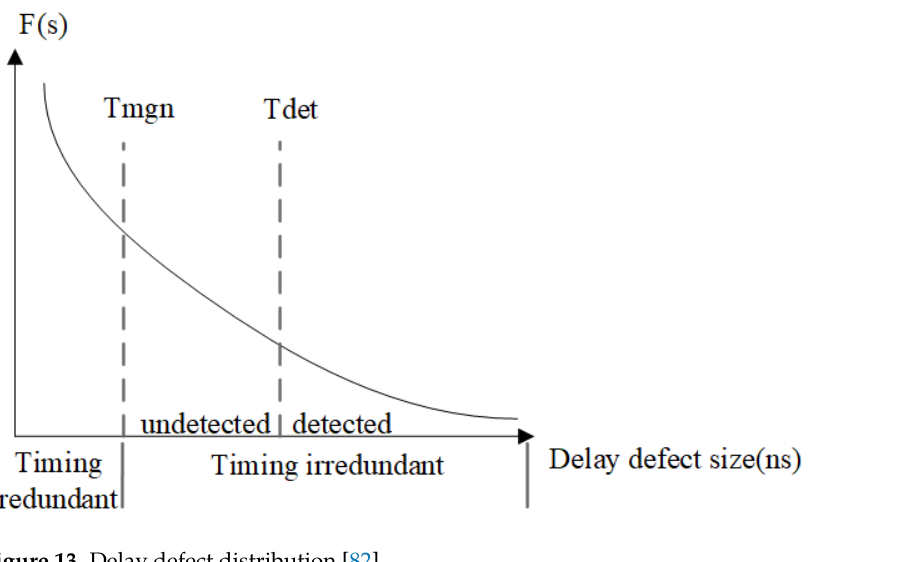
Figure 13. Delay defect distribution